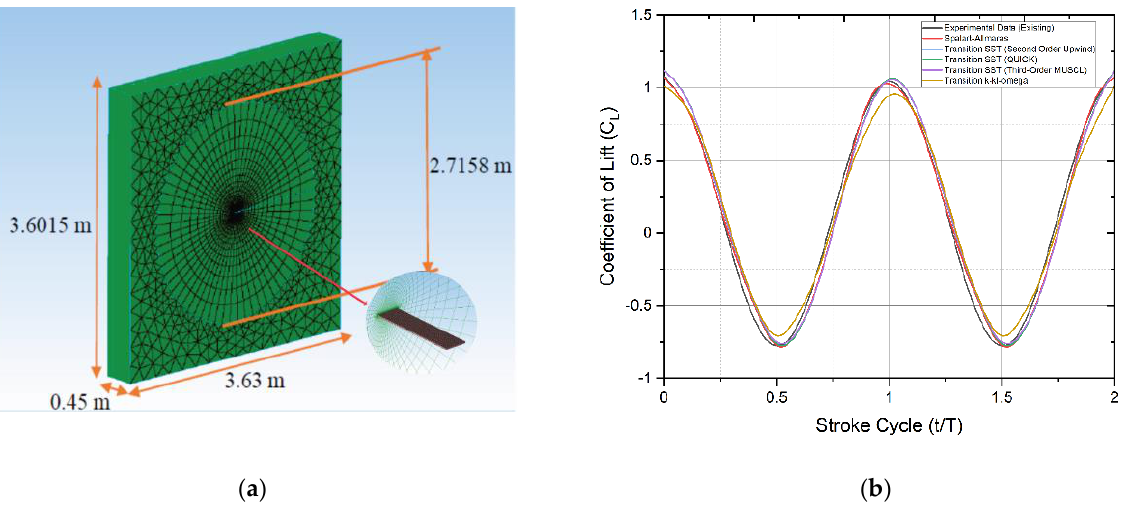
Figure 4. ( a ) Numerical setup for turbulence model validation; ( b ) lift distribution for a single stroke cycle for different turbulence models and their comparative study with available experimental data.